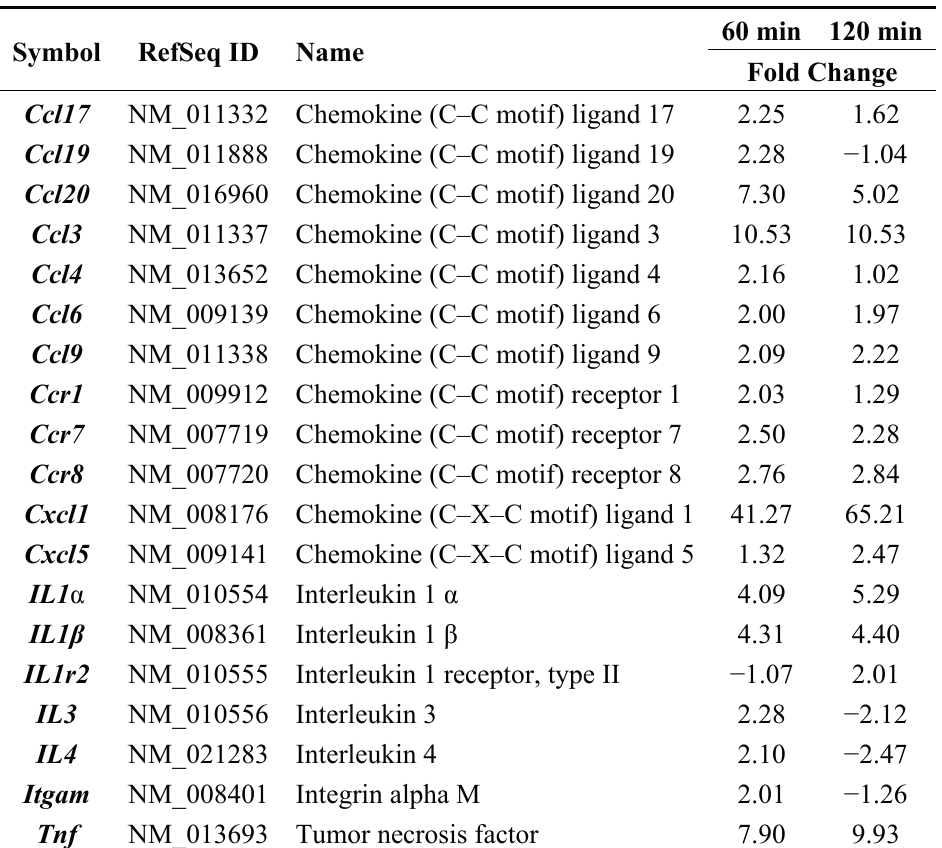
Table 1. Expression of C–C, C–X–C, interleukins (ILs) and TNF in 8-oxoG-challenged